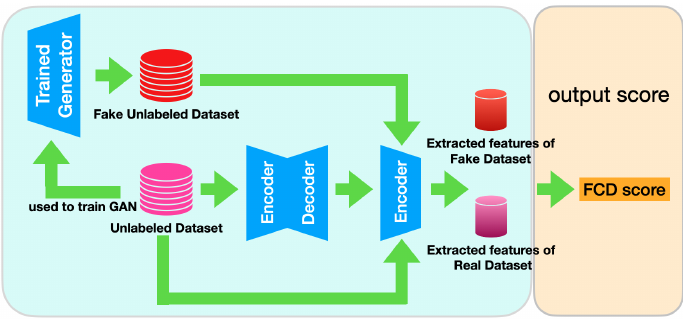
Figure 5. The architecture of an oracle instance based on FCD score.